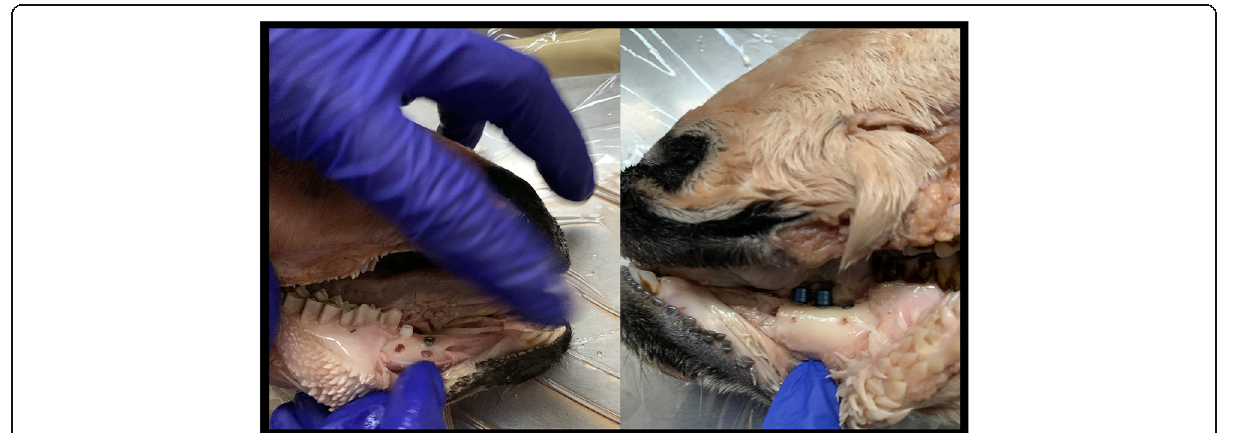
Fig. 1 Photo of the positioned implants and fenestration defects in the sheep ’ s jaw